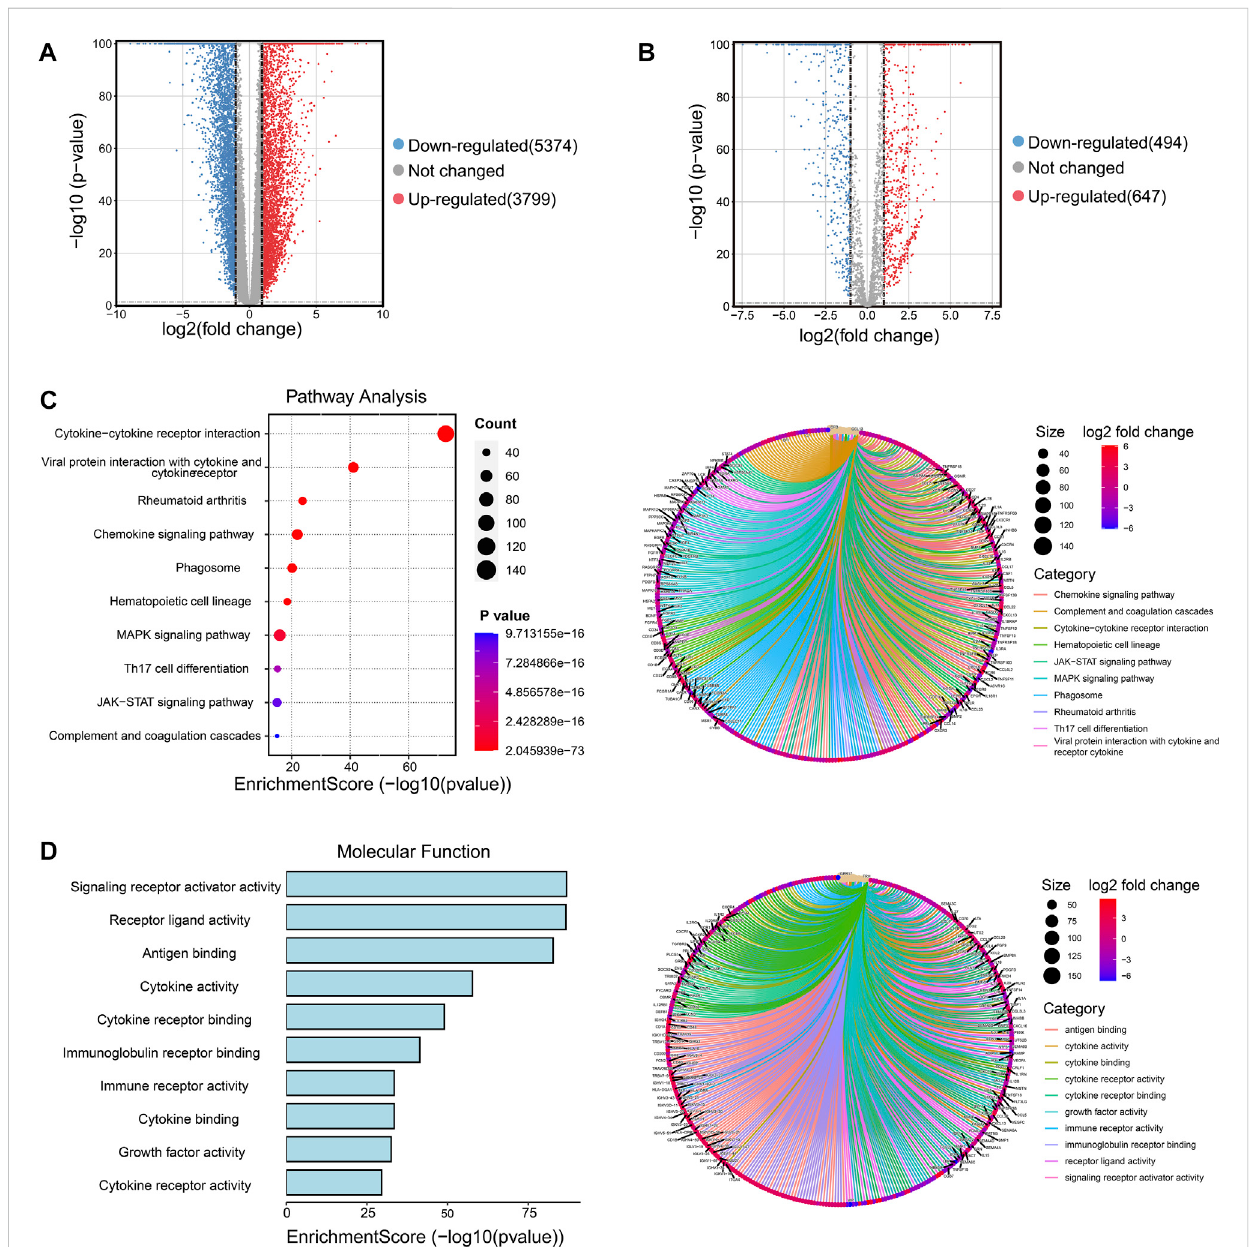
FIGURE 1 Screening the immune-related DEGs compared breast cancer tissues and normal breast tissues and identifying the functional enrichment of DEGs. (A) Volcanoplotillustratedthe9173DEGsbetweennormalbreastandtumortissues,downregulatedgeneswere5374andupregulatedgeneswere3799. Red plots represent upregulated genes and blue plots represent downregulated plots. (B) Volcano plot displayed the 1141 DEGs were recognized from 3210 immune-related pathway genes in normal and tumor samples, downregulated genes were 494 and upregulated genes were 647. (C) The top 10 pathways of 1141 DEGs were enriched and speci fi ed genes in the top 10 signal pathways were shown by a circle net diagram. (D) GO function analysis described the top 10 molecular functions of 1141 DEGs, and network analysis showed the representative genes and 10 biological